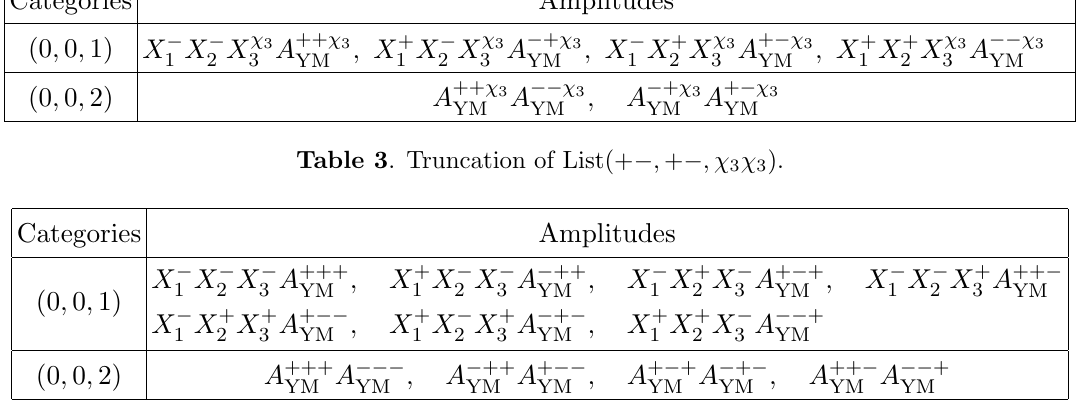
Table 4 . Truncation of List(+ (cid:0) ; + (cid:0) ; + (cid:0)